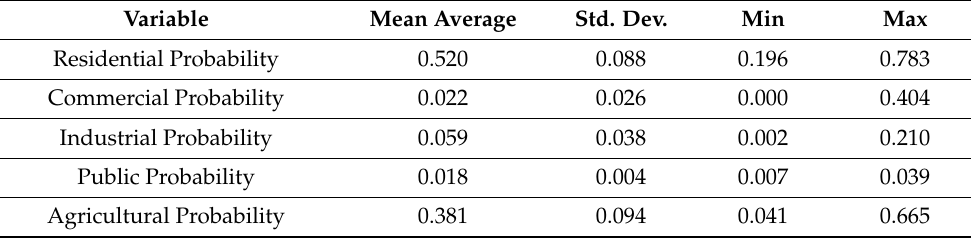
Table 4. Change in probabilities of use following the re-categorization of suburban areas to urban.